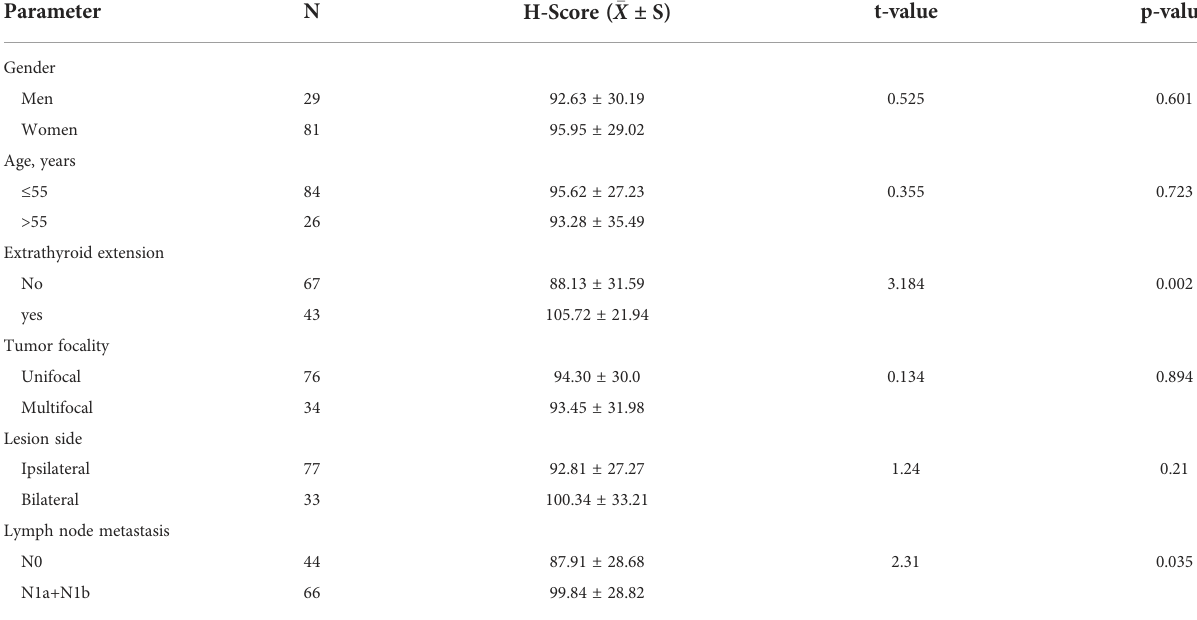
TABLE 2 Relationship between clinicopathological characteristics and expression of SIGLEC15 .